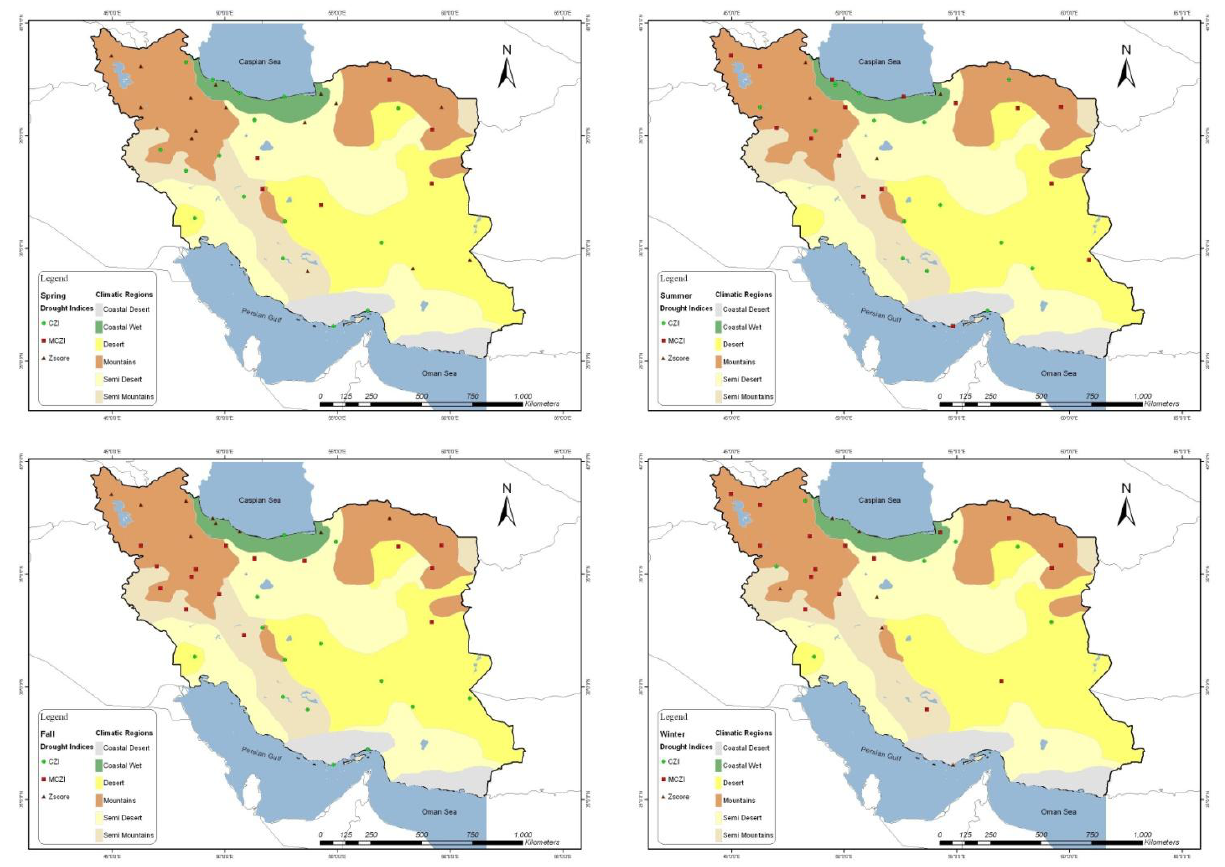
Figure 6. Spatial distribution of seasonal drought indices with the best correlation to SPI for spring, summer, autumn and winter